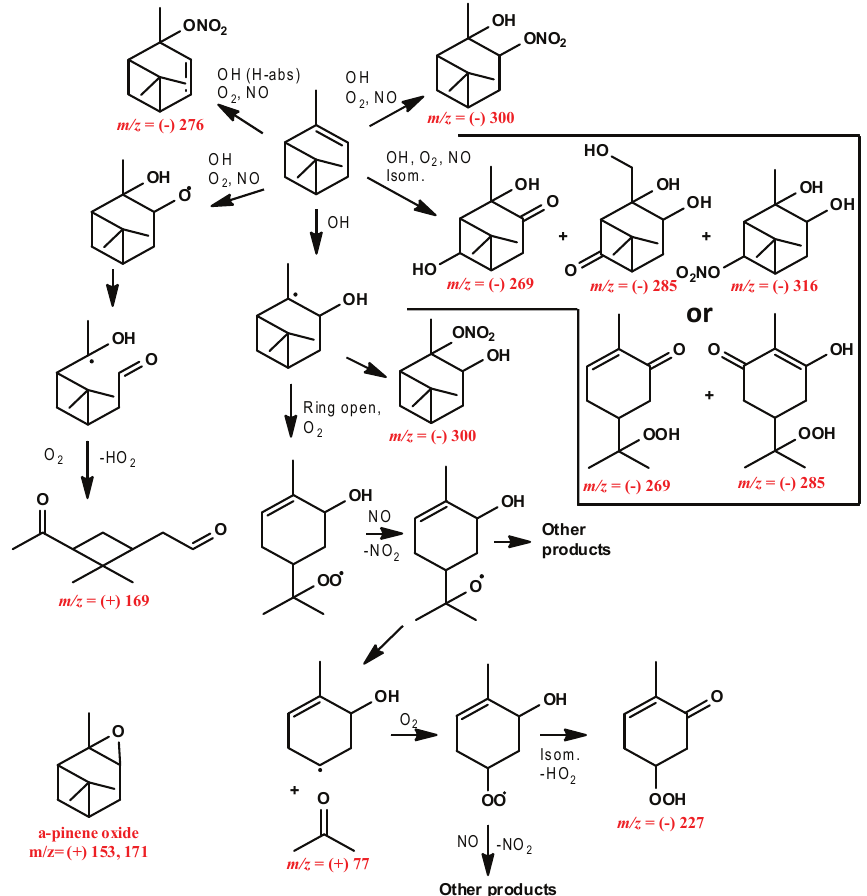
Fig. 7. Pathways of photooxidation of α -pinene under high-NO x conditions, the structures for m/z ( − )269 and ( − )285 (MW 184 and 200) are those proposed by Aschmann et al. (2002) and Vereecken et al. (2007). Ion of compounds detected by CIMS are indicated in